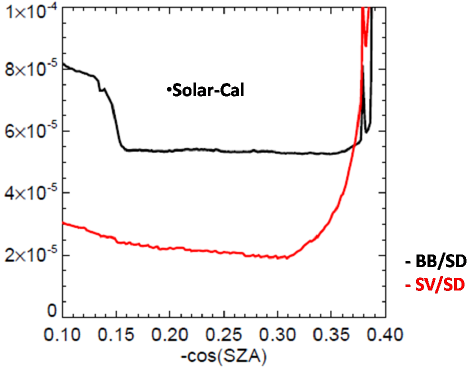
Figure 3. Mean ratios of BB/SD and SV/SD signals around solar calibration events on August 25, 2014. The dashed lines indicate the approximated solar calibration angle range. SZA = solar zenith angle.